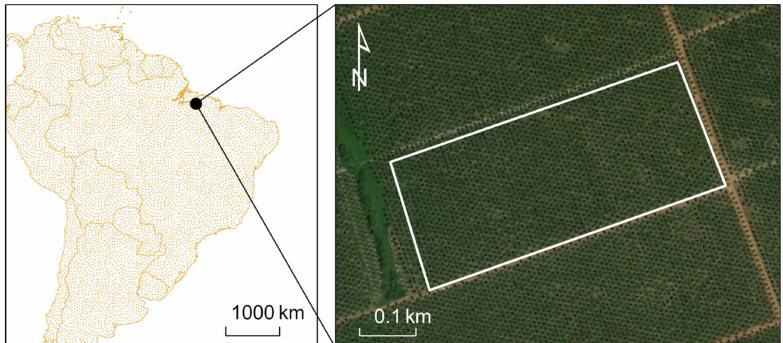
Figure 11. Google Earth image of the Brazil palm plantation near Para. The white outline indicates the study